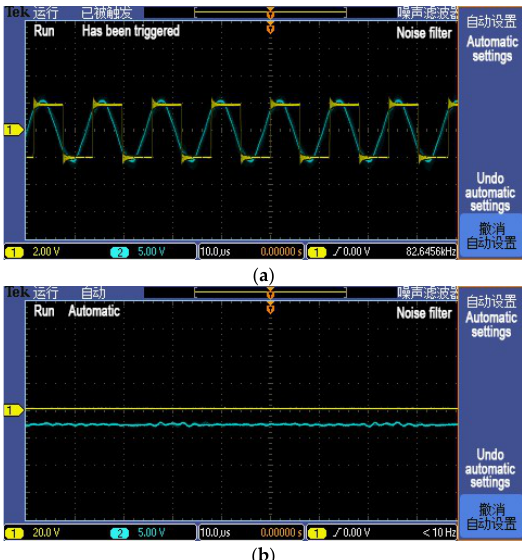
Figure 18. Sample value before and after the high-frequency inverter device under 12 cm distance without frequency adjustment. ( a ) High-frequency inverter device output voltage and primary coil current under 12 cm distance without frequency adjustment and ( b ) DC power output current under 12 cm distance without frequency